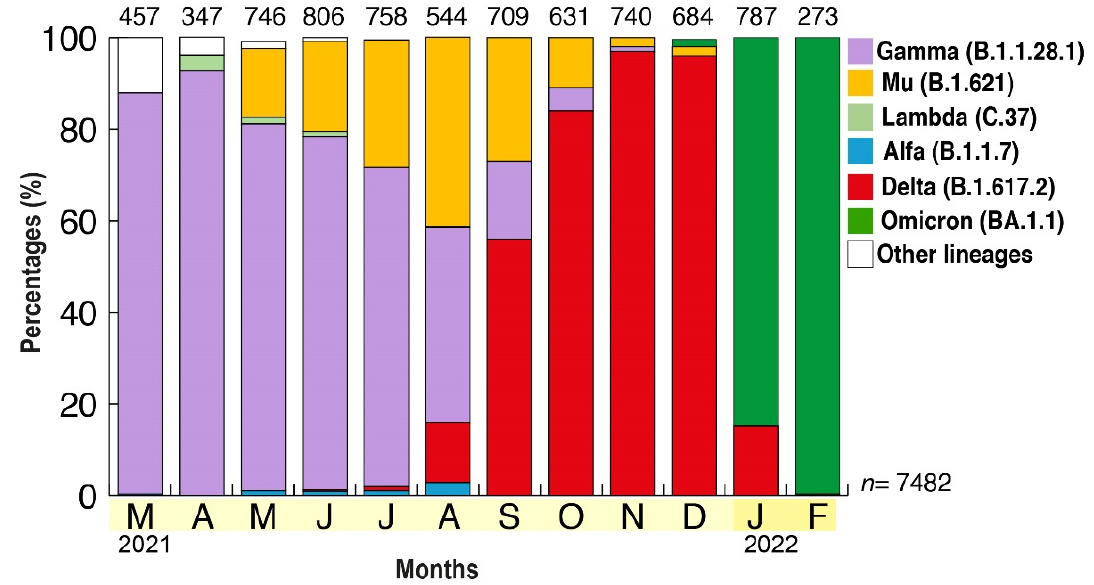
Figure 2. Prevalence of the different VOIs and VOCs in Venezuela from March 2021 to February 2022. The frequency of VOC is shown according to the month of collection of samples in the country. The average frequency was obtained by multiplying the frequency of variants by the population for each state, and then adjusting to 100% if not all the states were tested (see Supplemental Figure S1). The number above each bar refers to the number of samples analyzed each month, n = 7482 being the total number of samples analyzed.